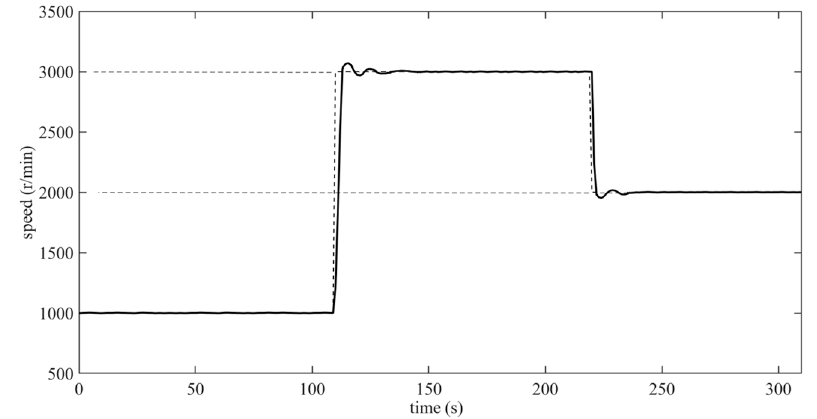
Figure 14. PWM speed regulation control based on the optimal range of switching angle.